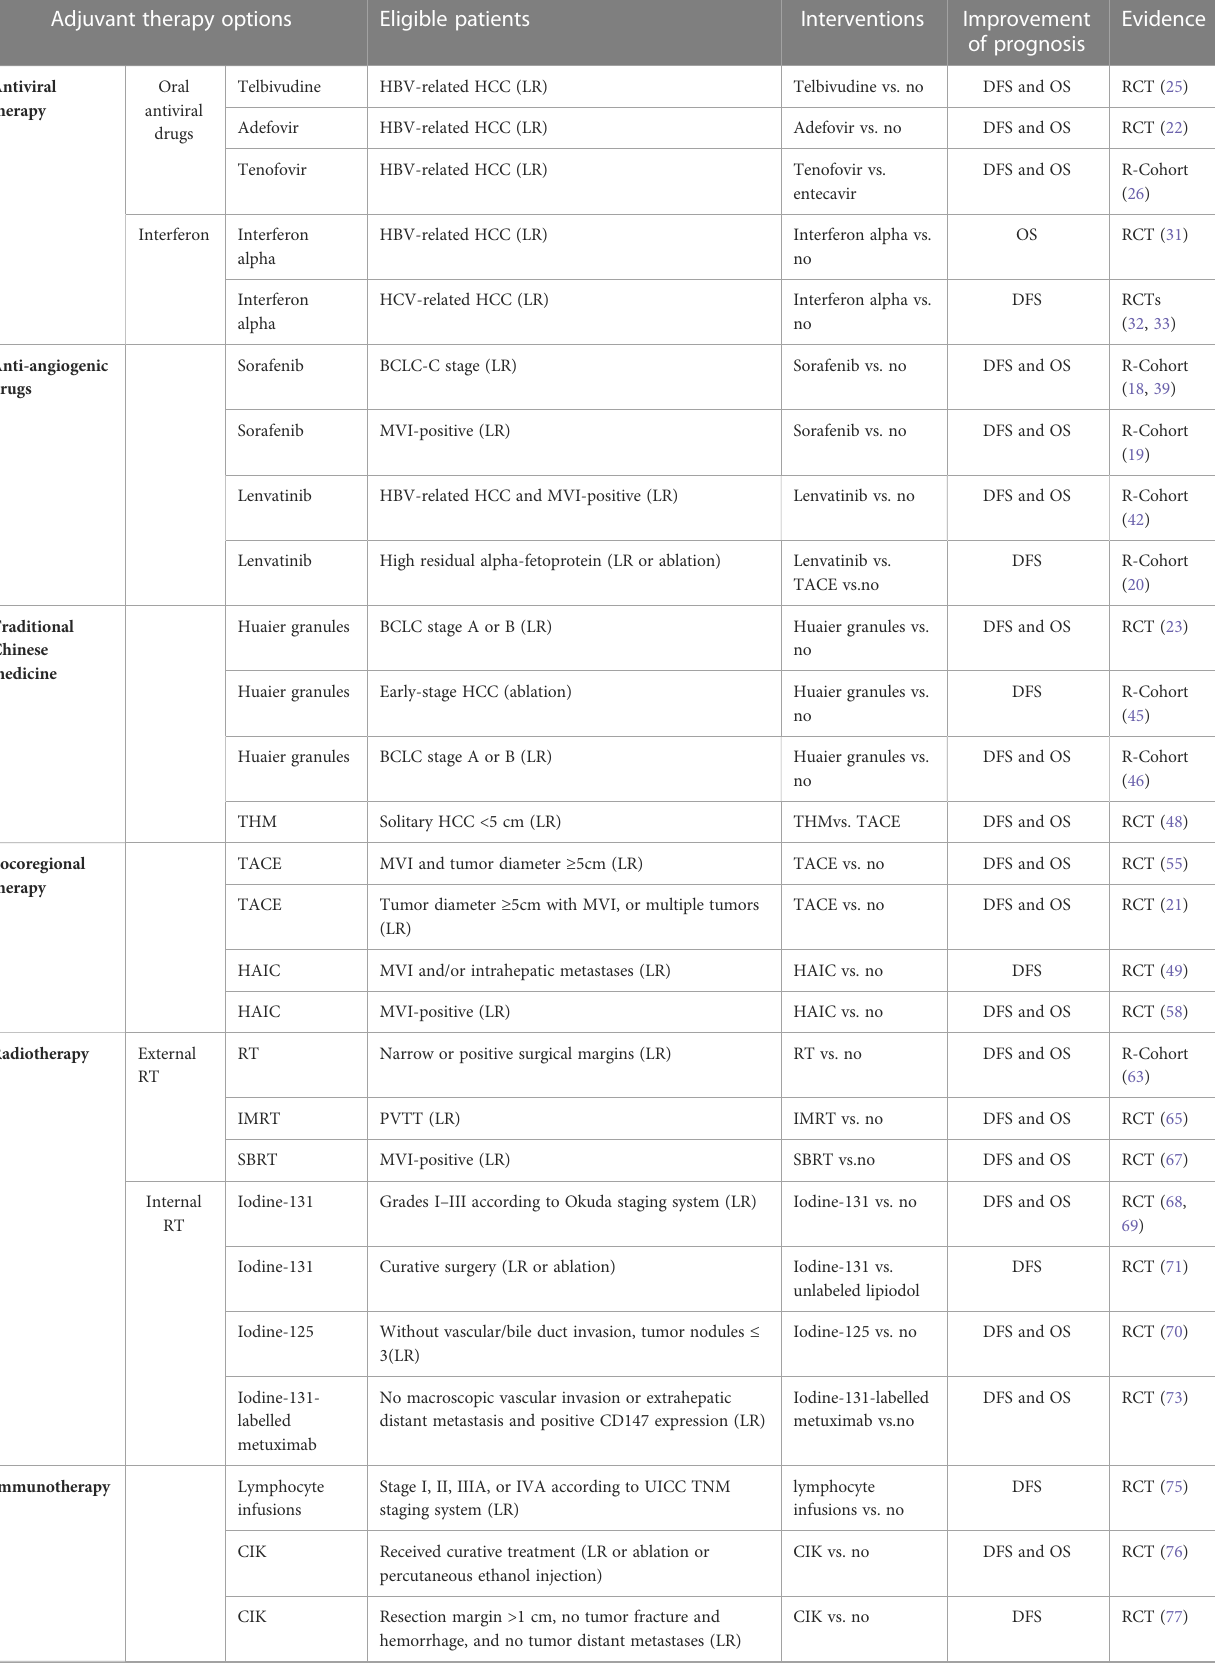
TABLE 2 Current adjuvant therapy options, improvement in prognosis, and the level of